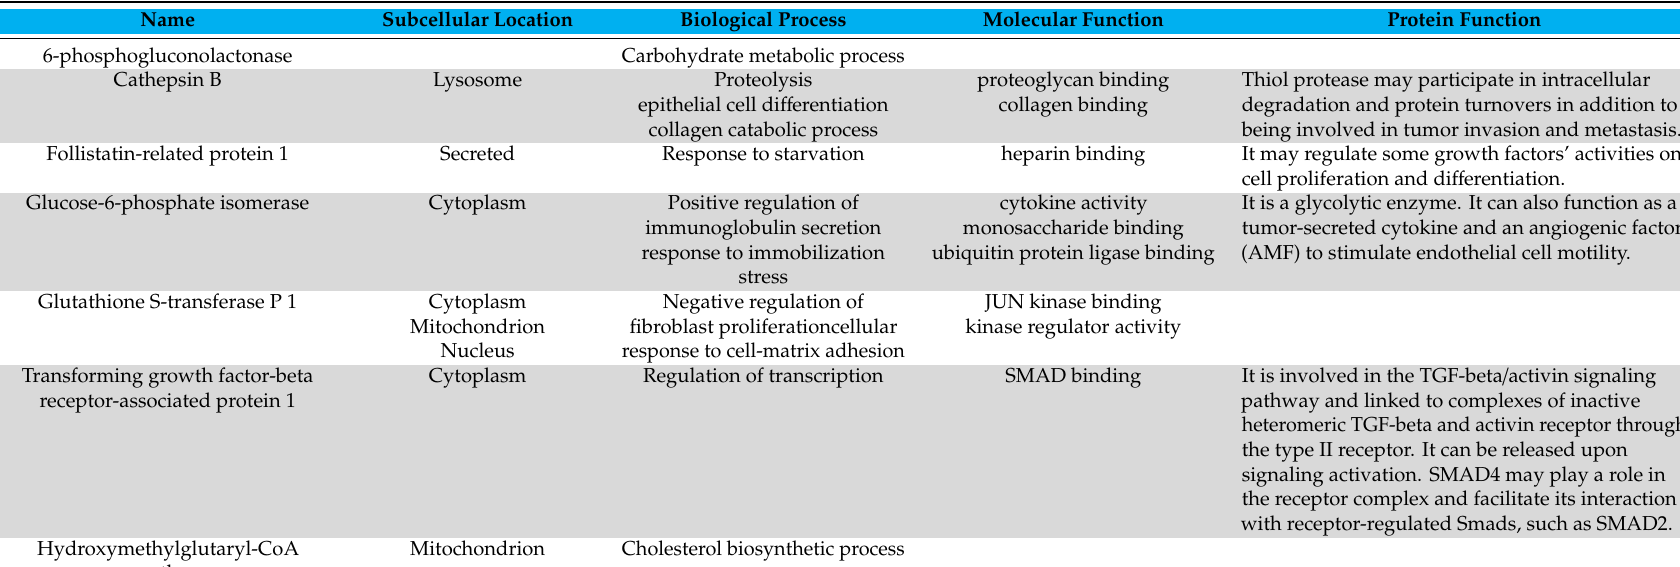
Table 2. Summary of protein function corresponding to tumorigenesis in HBx